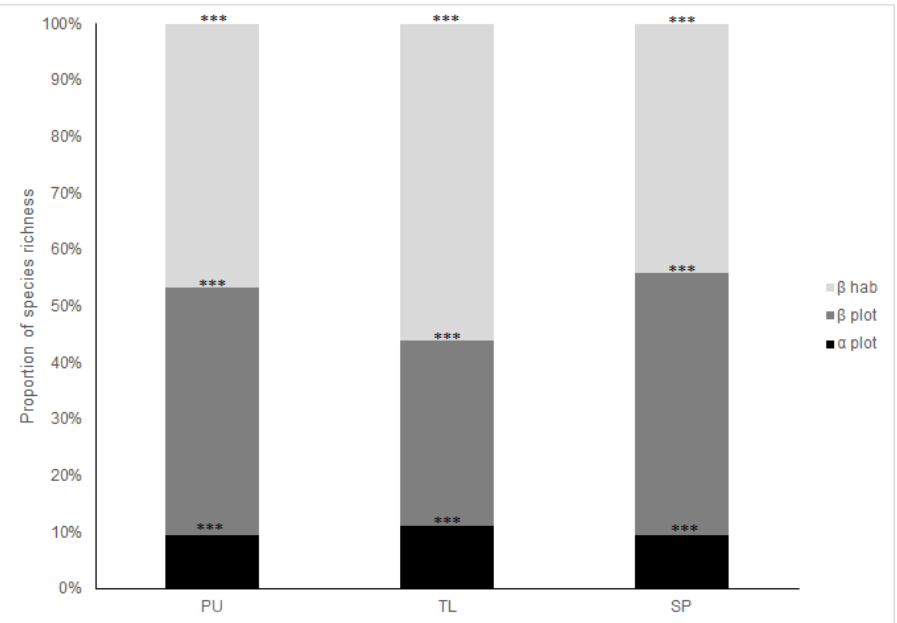
(RCs, dashed lines) calculated among habitats (left) and SACs (right). The dotted line (Random) represents the RC calculated from the whole species pool. Please note that this curve was truncated according to the maximum number of plots detected in each factor. TL = Torre del Lago; PU = Parco Uccelllina; SV = Selva Pisana.